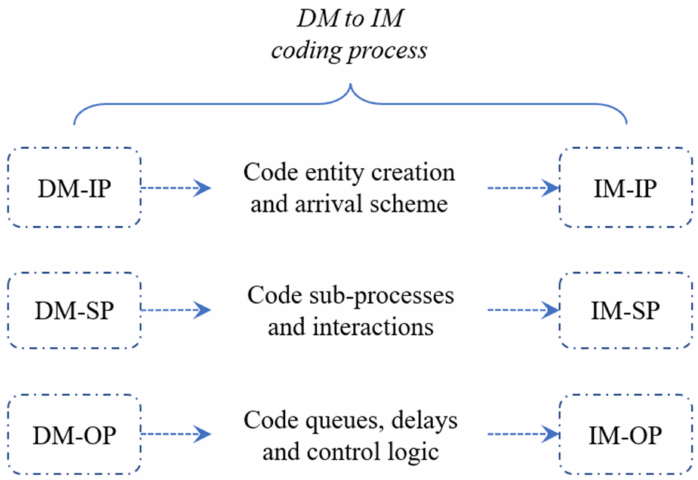
Figure 15. Converting the Design Model to an Implementation Model.